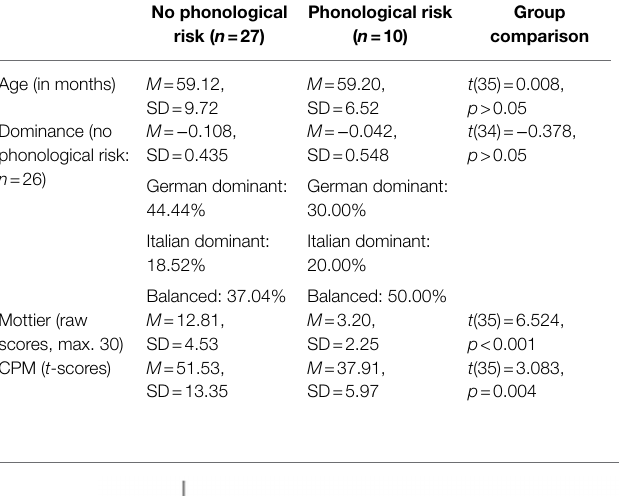
TABLE 2 | Description of the sample at T1 grouped according to phonological risk status, and t-test